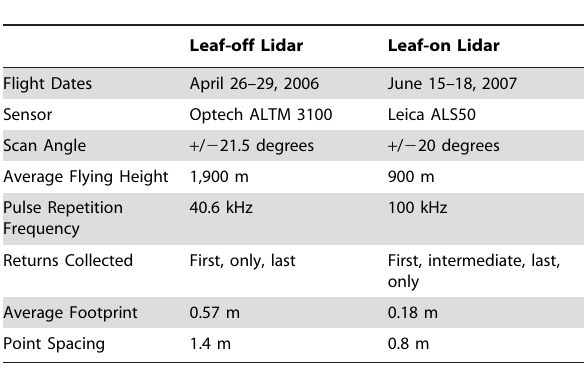
Table 1. Leaf-off and leaf-on lidar survey specifications.